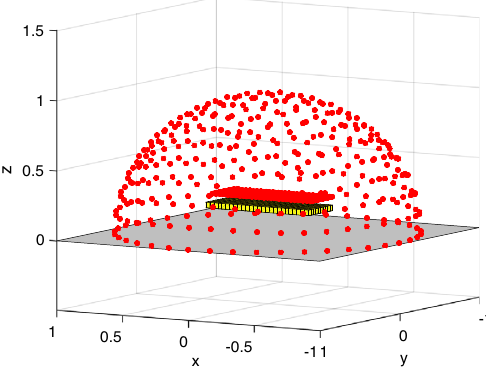
Figure 2. The plate above the ground in combination and two sets of receiving positions. One set directly above the plate and one set distributed on a sphere.